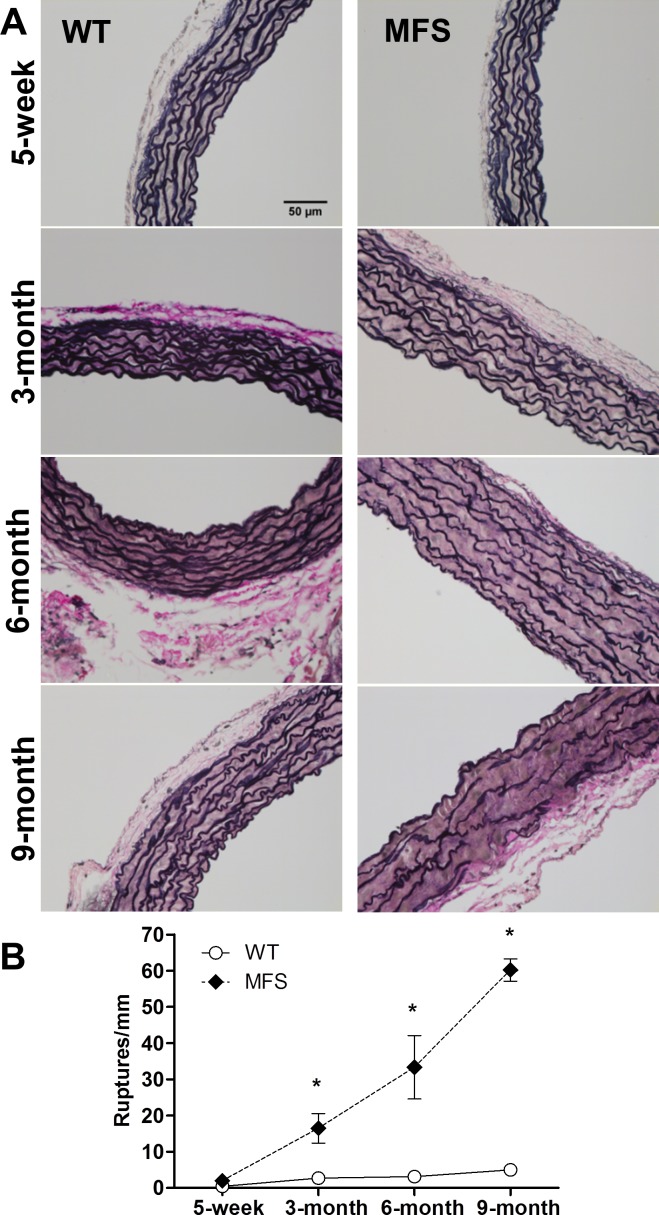
Tunica media fibers integrity in WT and MFS mice aortas.(A) Representative images from ascending aortas in WT and Marfan (MFS) mice processed and evaluated for elastic tunica media fibers integrity. Histological sections were stained with Verhoeff-Van Gieson. Images acquired at 40x magnification and scale bar represents 50μm.(B) Elastic fiber ruptures in the tunica media of the ascending aorta. Data are mean ± SE. *: p<0.05 between WT and Marfan animals